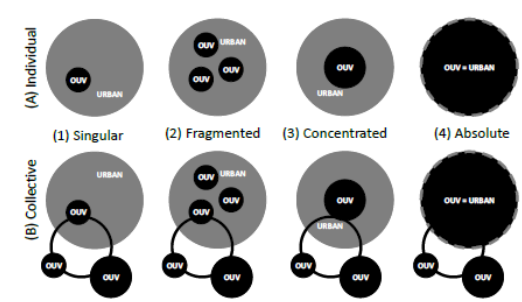
Figure1 Identified patterns (image from Pereira,